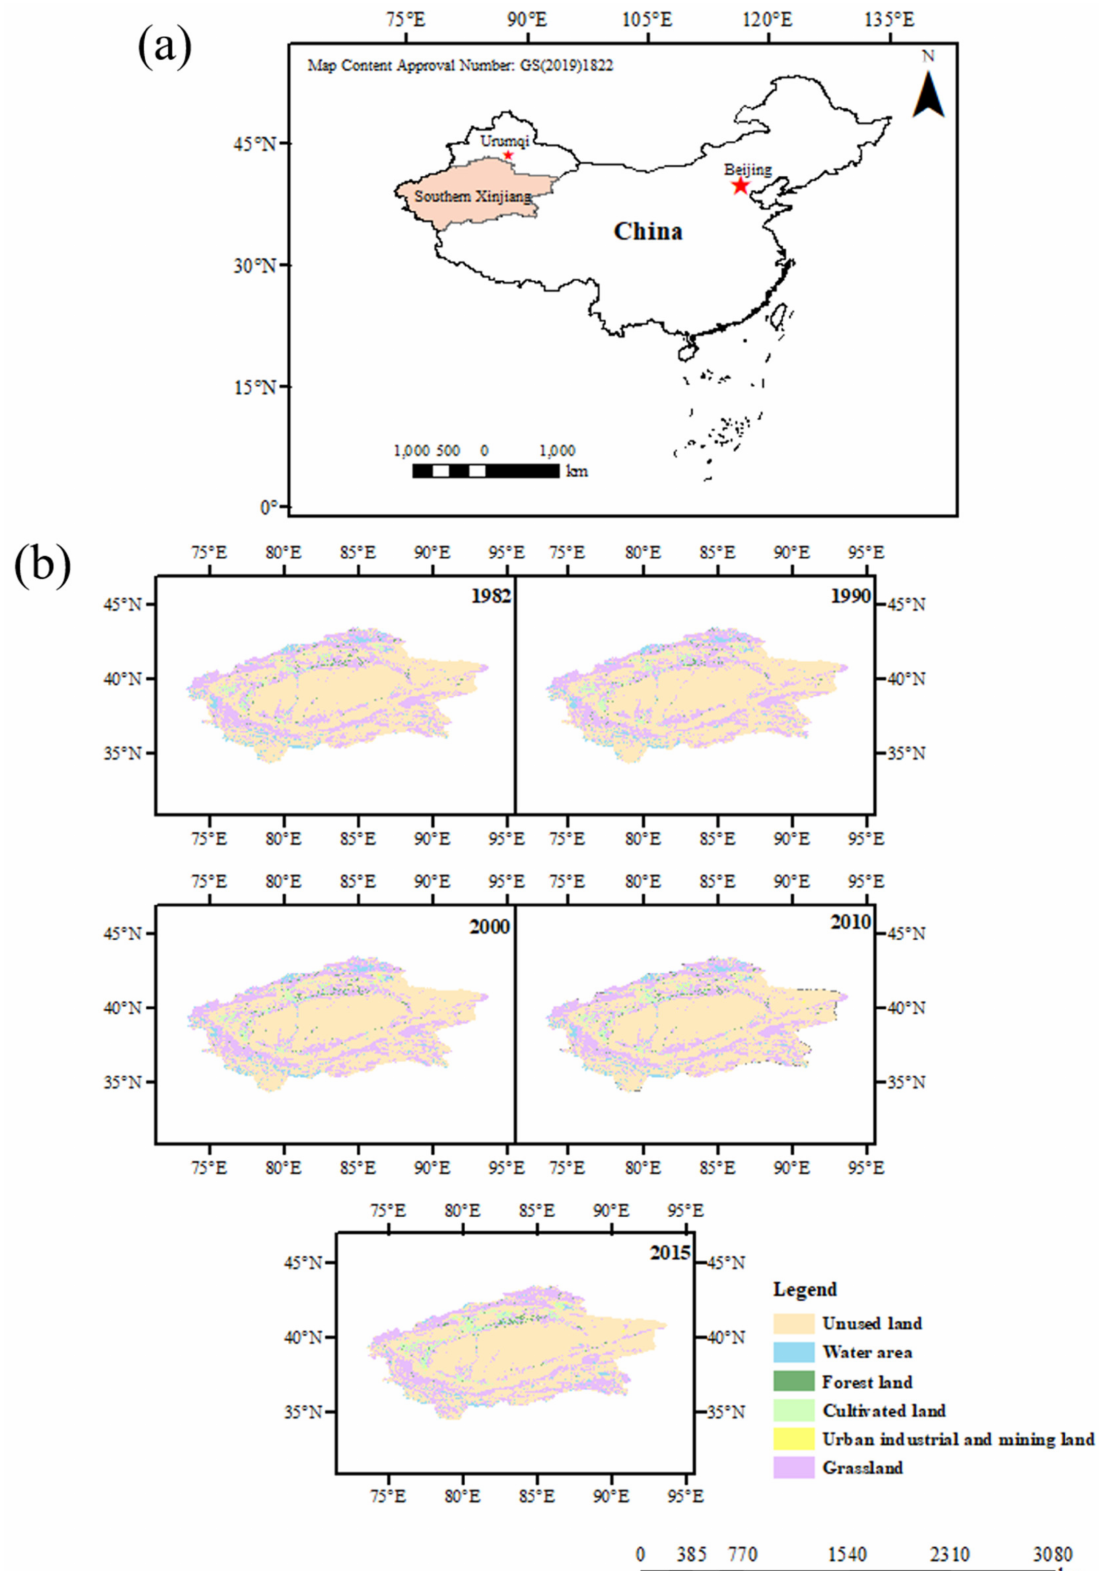
Figure 1. ( a ) Location map of the study area. ( b ) Land-use type changes in southern Xinjiang from 1982 to